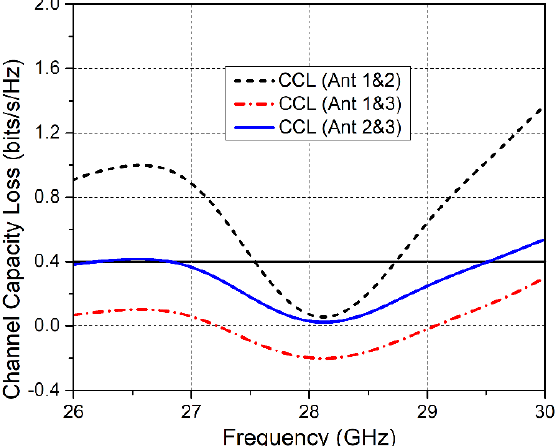
Figure 15. CCL of the proposed MIMO antennas.